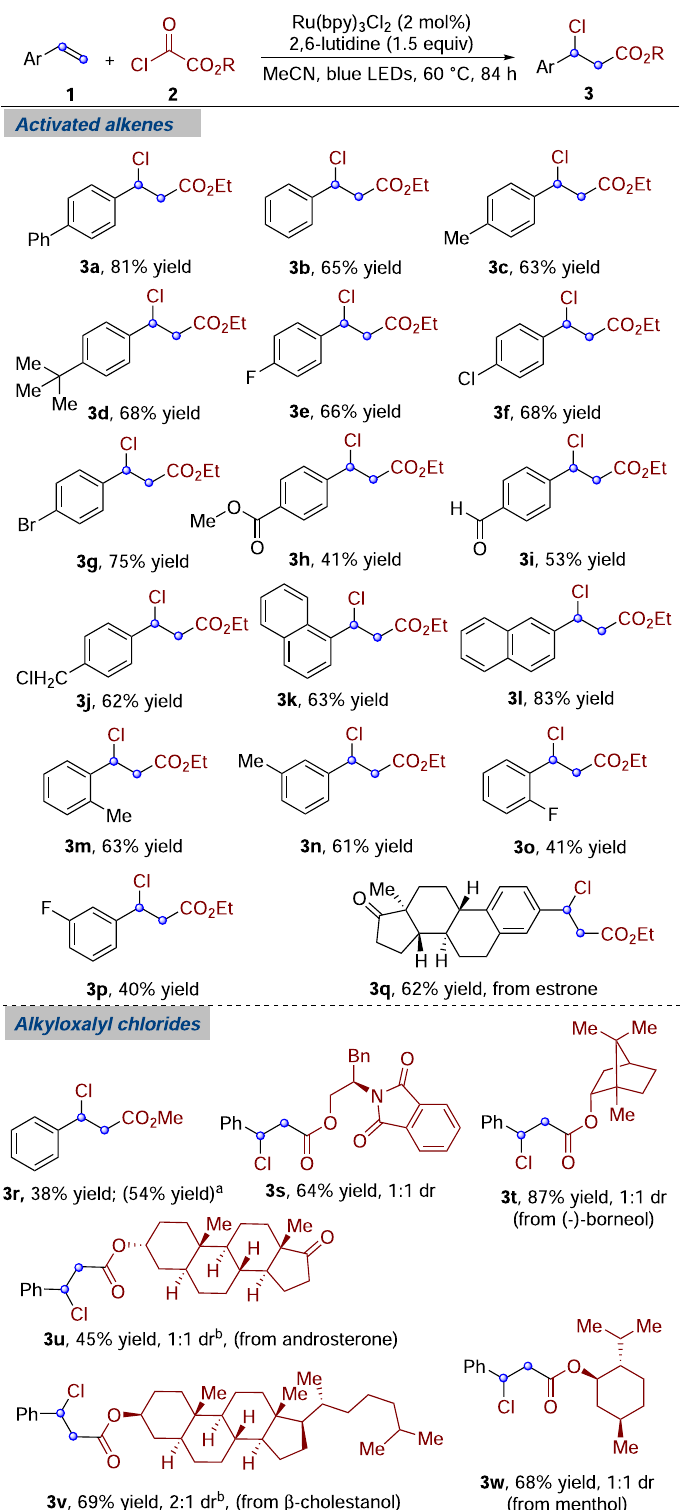
Fig. 2 Alkoxycarbonylchlorination with activated alkenes. Reaction conditions: activated alkene 1 (0.2 mmol), alkyloxalyl chloride 2 (0.6 mmol), Ru(bpy) 3 Cl 2 (2 mol %), 2,6-lutidine (0.3 mmol), anhydrous MeCN (4.0 mL), blue LEDs, 60 °C, 84 h, under N 2 atmosphere. Isolated yields. The dr values were determined by 1 H NMR analysis. a Alkyloxalyl chloride 2 (1.0 mmol). b Determined by HPLC